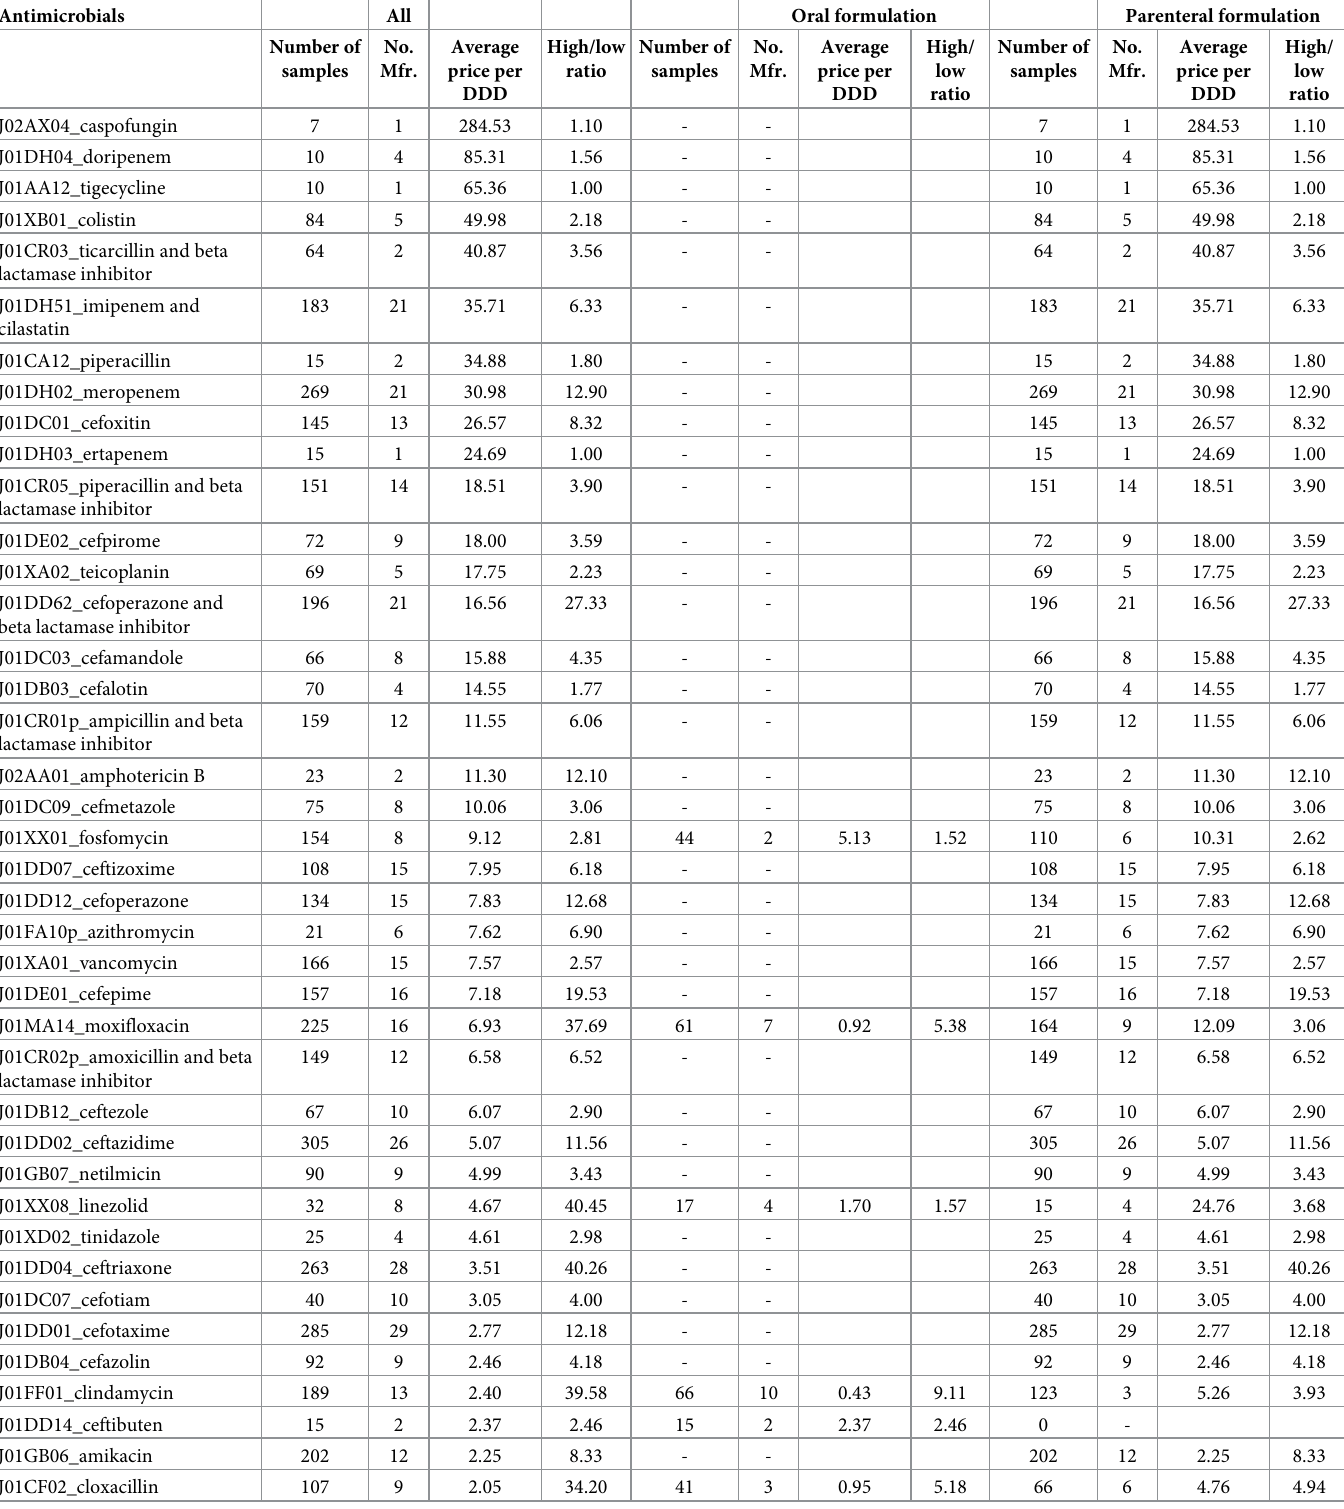
Table 3. Prices of antimicrobials.